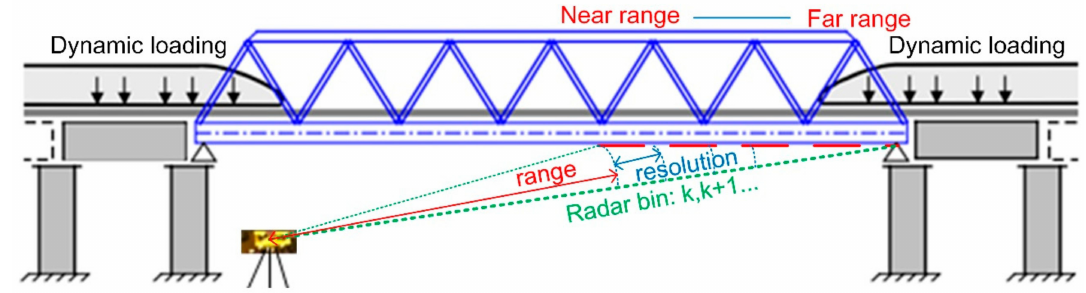
Figure 1. Scheme of interferometric radar for monitoring a bridge.